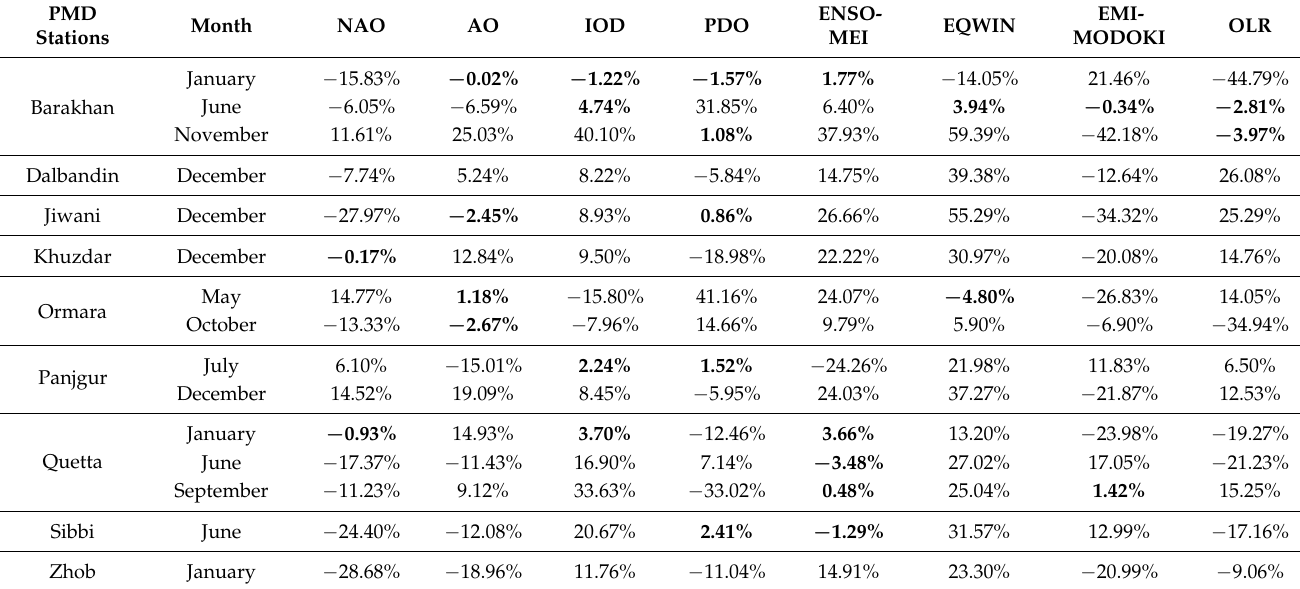
Table 3. Correlation of precipitation at individual stations with climatic indices.